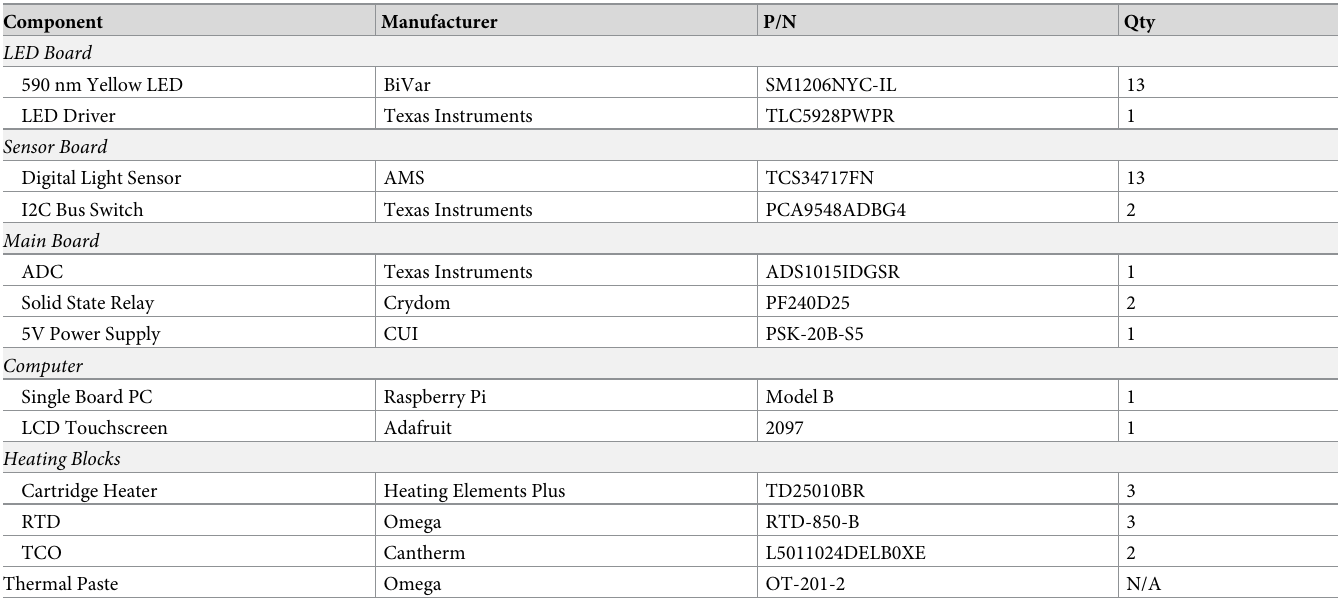
Table 1. Bill of materials for critical